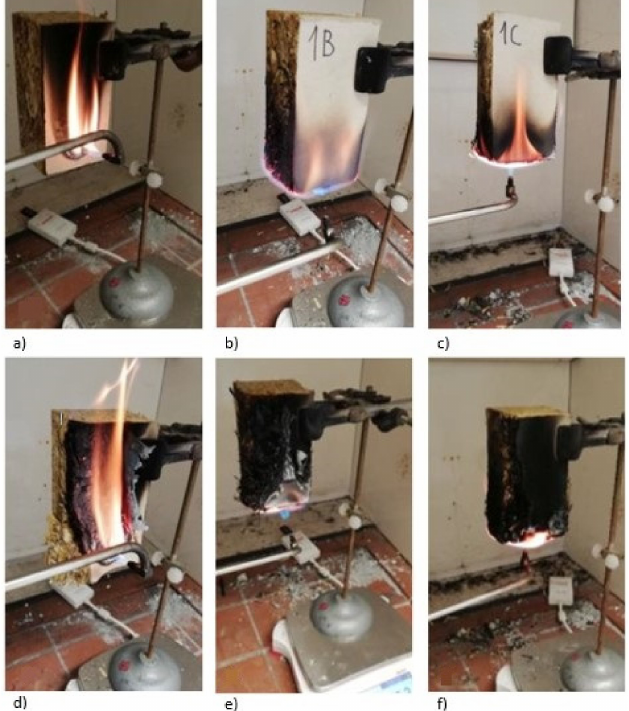
Figure 3. Location of the burner in the experiments in the first minute ( a – c ) and 3rd minute ( d – f ) for samples A ( a , d ); B ( b , e ); C ( c , f